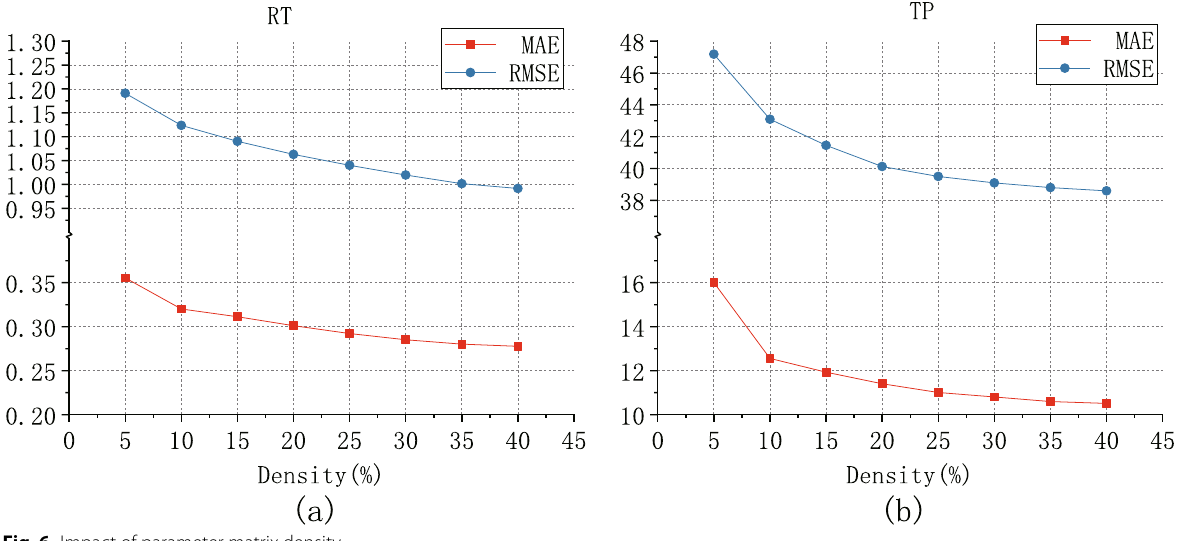
Fig. 6 Impact of parameter matrix